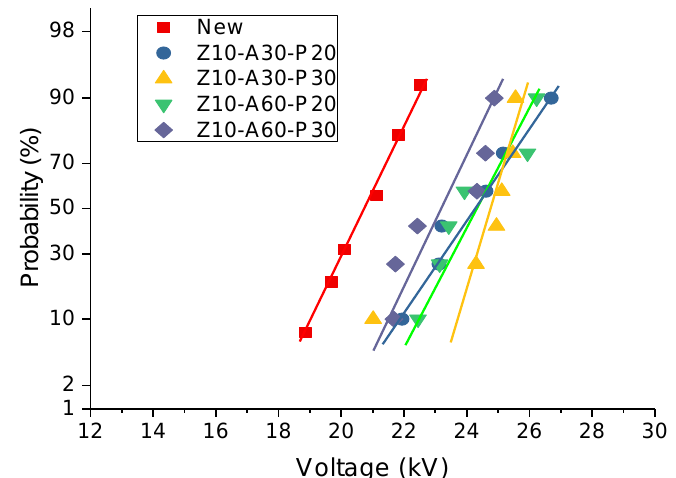
Figure 14. The two-parameter Weibull distribution of AC breakdown voltage. Table 3. Scale parameter and shape parameter of two-parameter Weibull distribution.